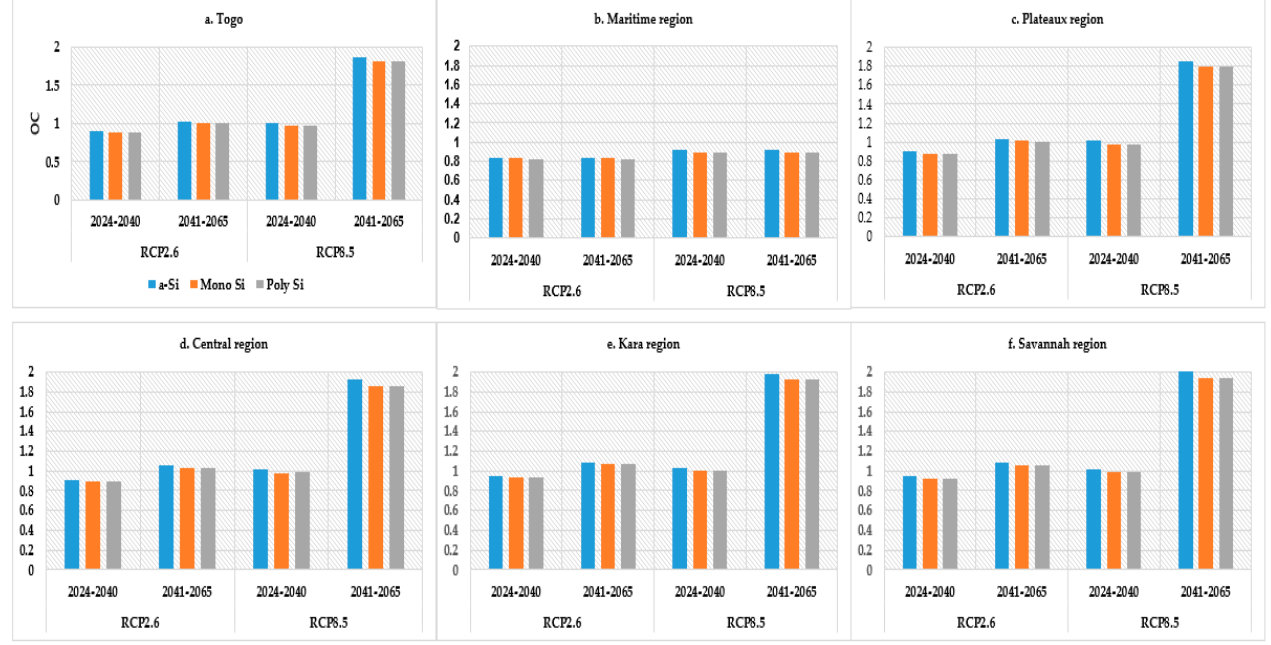
Figure 8. Monthly mean cells’ temperature under RCP2.5 and 8.5 and technology, Togo.